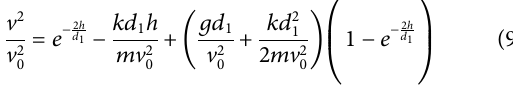
Frontiers in Earth Science |